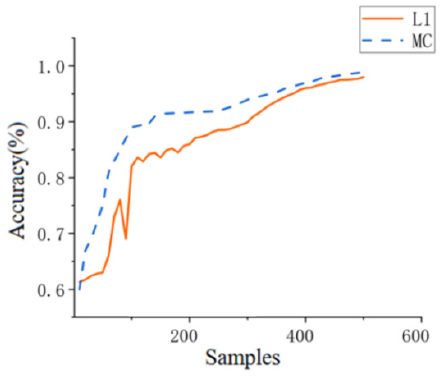
Figure 5. Accuracy changes under different input sample sizes.